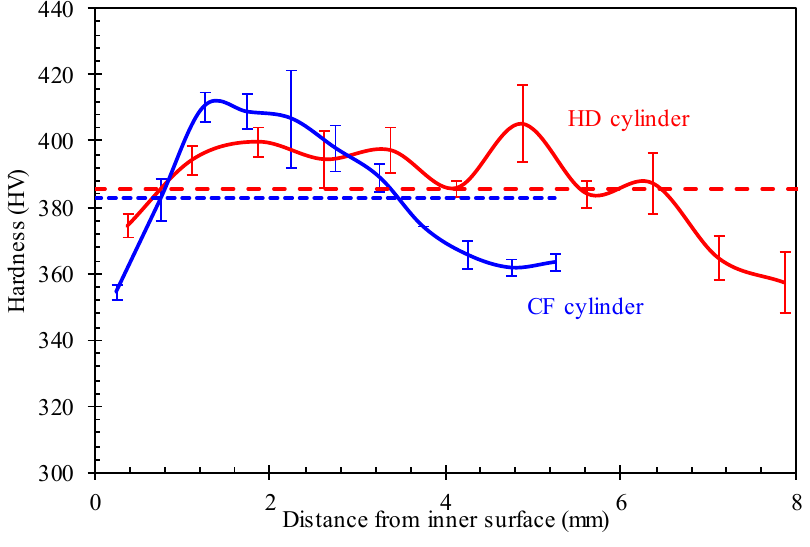
Figure 6. Measured hardness along the radial direction from the inner to the outer surface for the HD and CF cylinders.